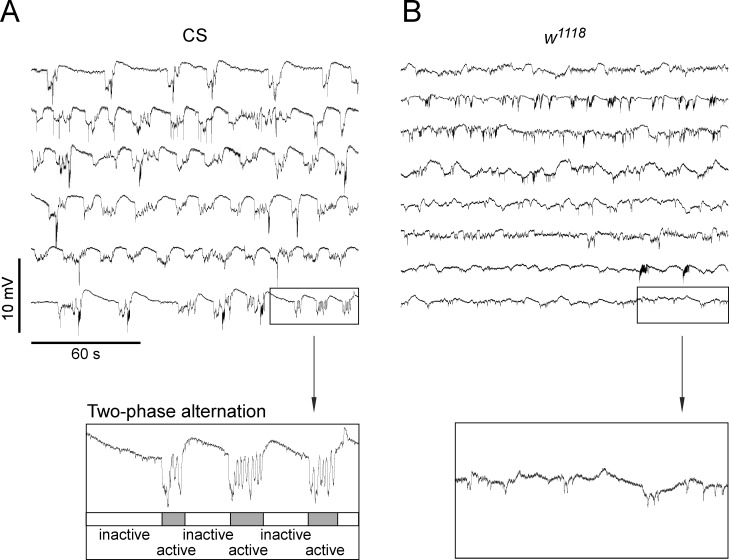
Reduced periodicity of centrally-generated motor pattern in w1118 male flies without pulsed light treatment.(A) Extracellular recordings in the middle brain in wild-type CS male flies without pulsed light treatment. Each trace represents the recording from a single fly. The inset shows a typical alternation of inactive/active phases (with relatively longer duration for inactive phase). (B) Recordings from the mutant w1118 male flies without pulsed light treatment. Inset indicates the apparent loss or reduction of two-phase alternation of extracellular electrical activity.